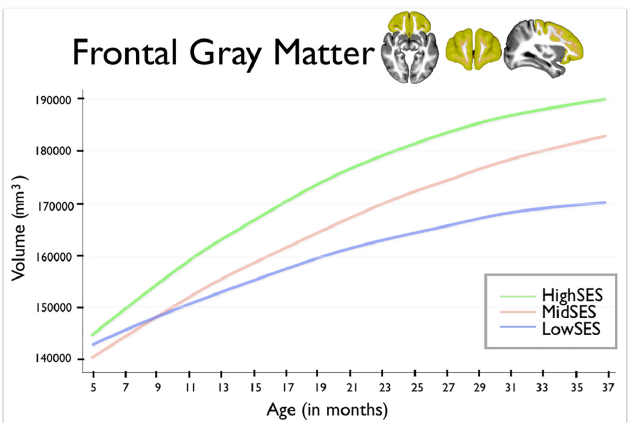
Fig 3. This figure shows frontal lobe gray matter volumes for group by age. Age in months is shown on the horizontal axis, spanning from 5 to 37 months. Total gray matter volume is shown on the vertical axis. The blue line shows children from Low SES households; children from Mid SES households are shown in red. The green line shows children from High SES